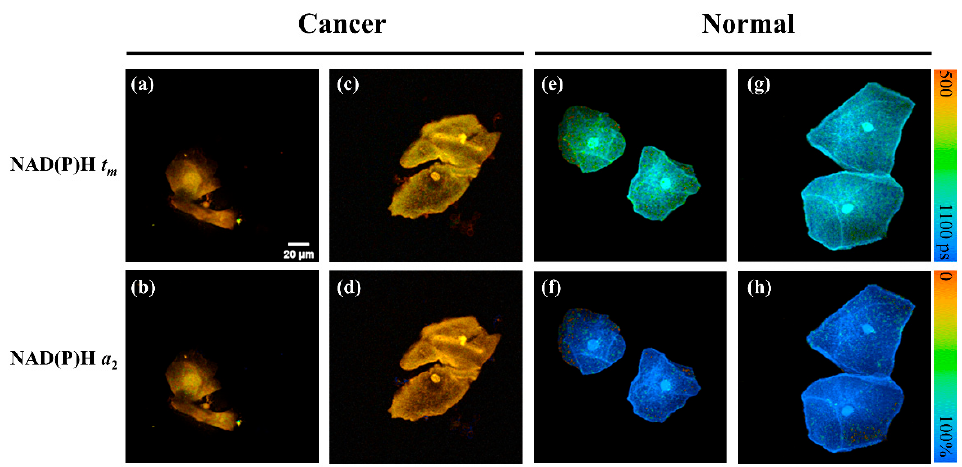
Figure 1. Typical FLIM images of unstained exfoliated cervical cells from four participants (each column is from one person); ( a – d ) are from two cervical cancer patients and ( e – h ) are from two normal cases where the autofluorescence is from the intracellular NAD(P)H; t m means the mean fluorescence lifetime of NAD(P)H; and a 2 means the contribution of protein-bound NAD(P)H. Scale bar: 20 µm.